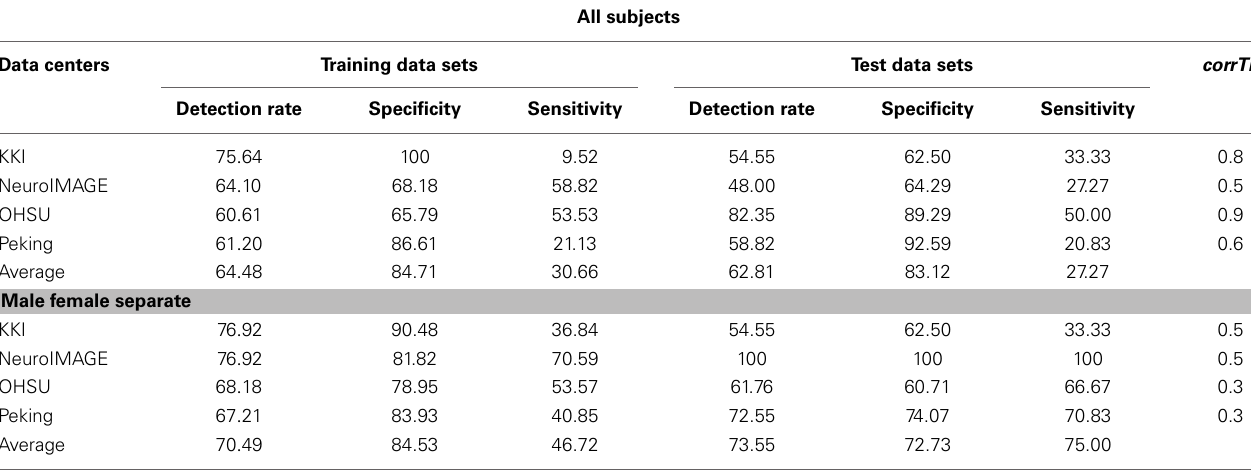
Table 3 | Summary of the results: table shows the best detection rates achieved (along with their specificities and sensitivities) on all the training sets using the proposed method.